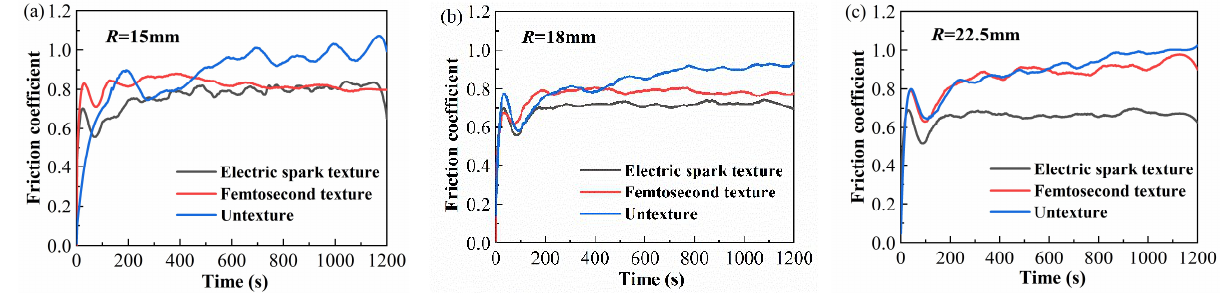
Figure 5. Friction-coefficient curves of different samples: ( a ) rotation radius 15 mm; ( b ) rotation radius 18 mm; ( c ) rotation radius 22.5 mm.